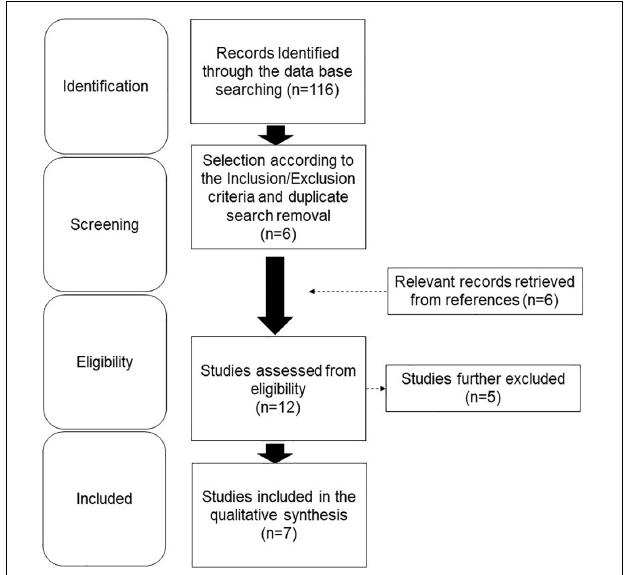
FIGURE 2 | Flow diagram showing the search strategy, the number of records identified, and the number of included/excluded studies.